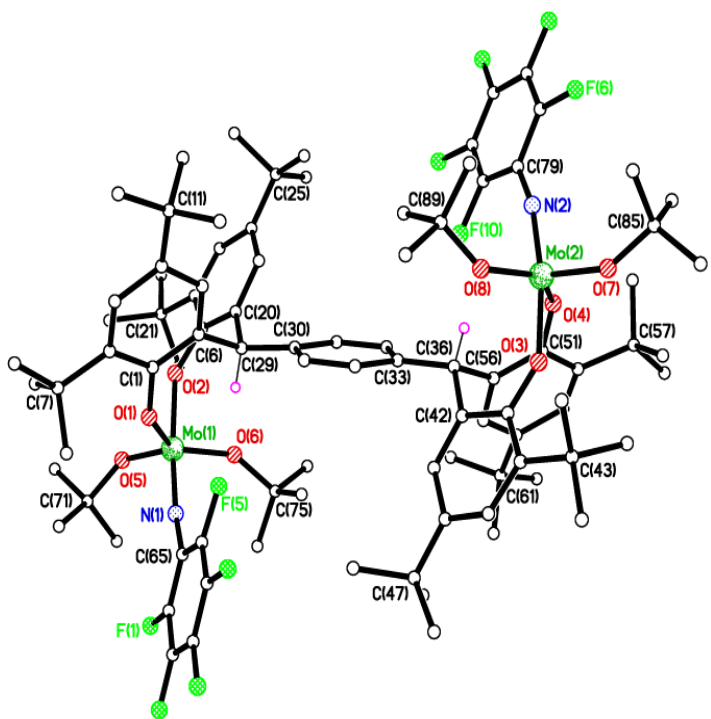
Figure 6. Molecular structure of {[Mo(NC 6 F 5 )(O t -Bu) 2 ] 2 ( μ -L 3p )}·6MeCN ( 7 ·6MeCN), showing the atom numbering scheme for one of the two similar molecules in the asymmetric unit. Most H atoms and solvent molecules of crystallization omitted for clarity. Selected bond lengths (Å) and angles (°): Mo(1)–O(1) 1.921(5), Mo(1)–O(2) 1.945(5),